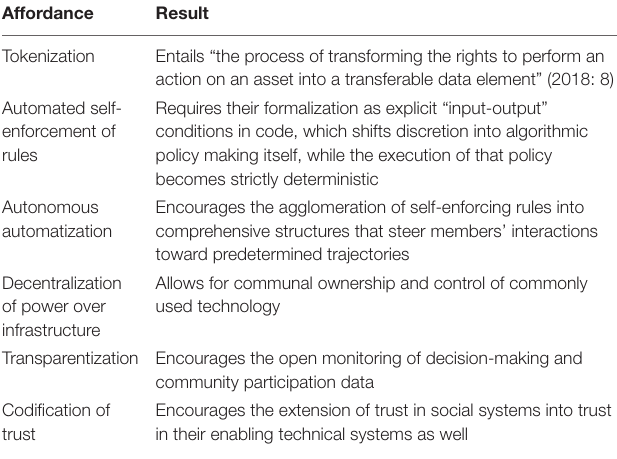
TABLE 1 | Blockchain affordances for commoning, per Rozas et al.